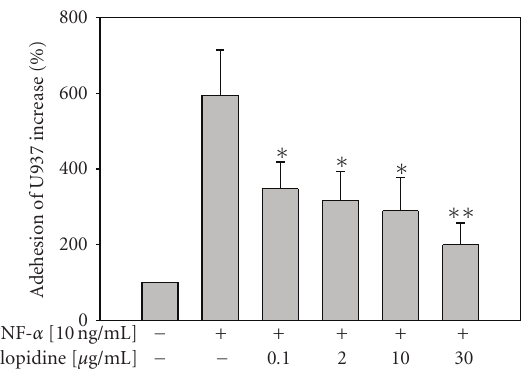
Figure 4: Reduction of monocyte (U937) adhesion by ticlopidine. HUVECs were incubated with serum-free medium for 12hours before di ff erent concentrations of ticlopidine were added, after 12hours incubation cells were stimulated with/without TNF- α (10ng/mL) for another 24 hours. Adhesion of fluorescence-labeled U937 cells was determined by adhesion assay. Data are expressed as the mean ± SEM of five individual experiments. Significantly di ff erent versus TNF-treated alone ∗ P < .05, ∗∗ P < .001. decreased TNF- α -induced U937 cells adhesion by 347.7 ± 70.88% ( P = .032).